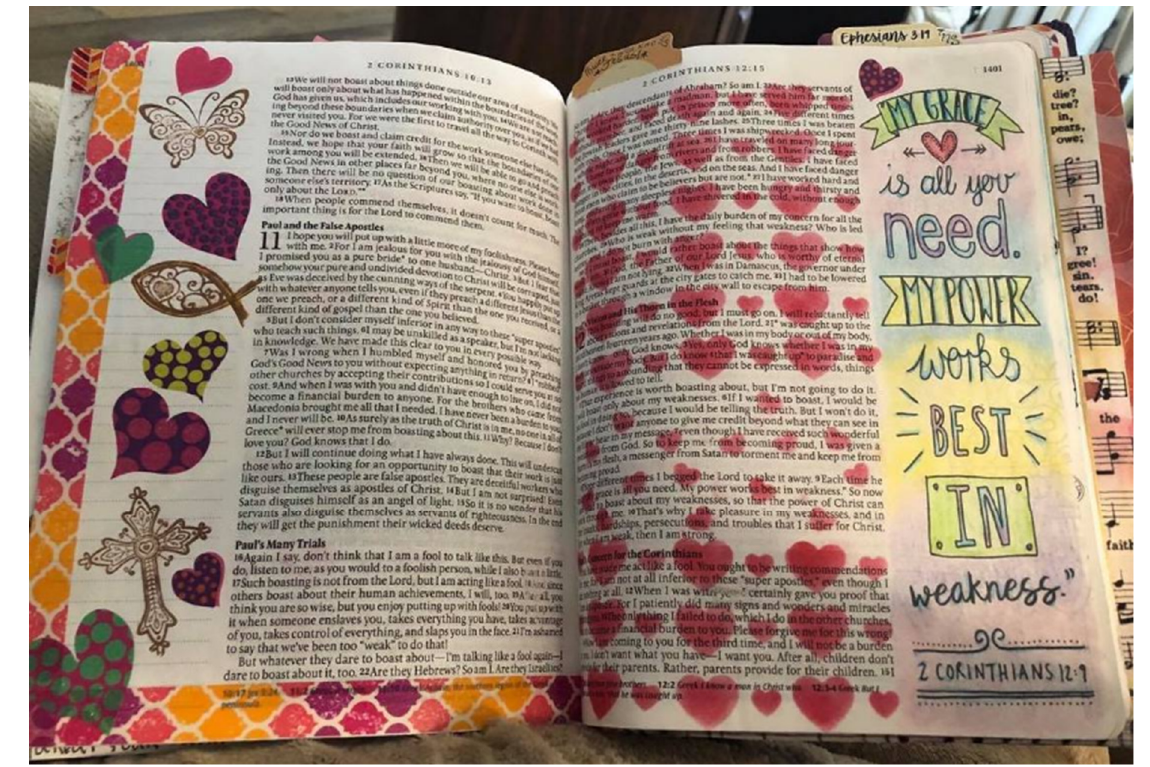
Figure 6. 2 Corinthians 12:9. With kind permission of the journaler.